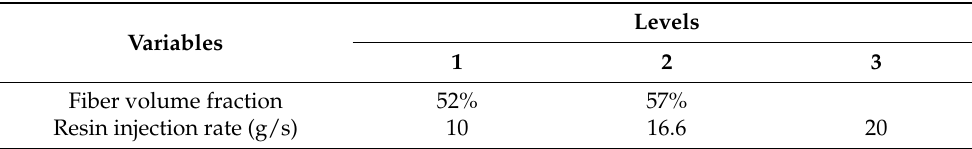
Table 2. Experimental factors and corresponding